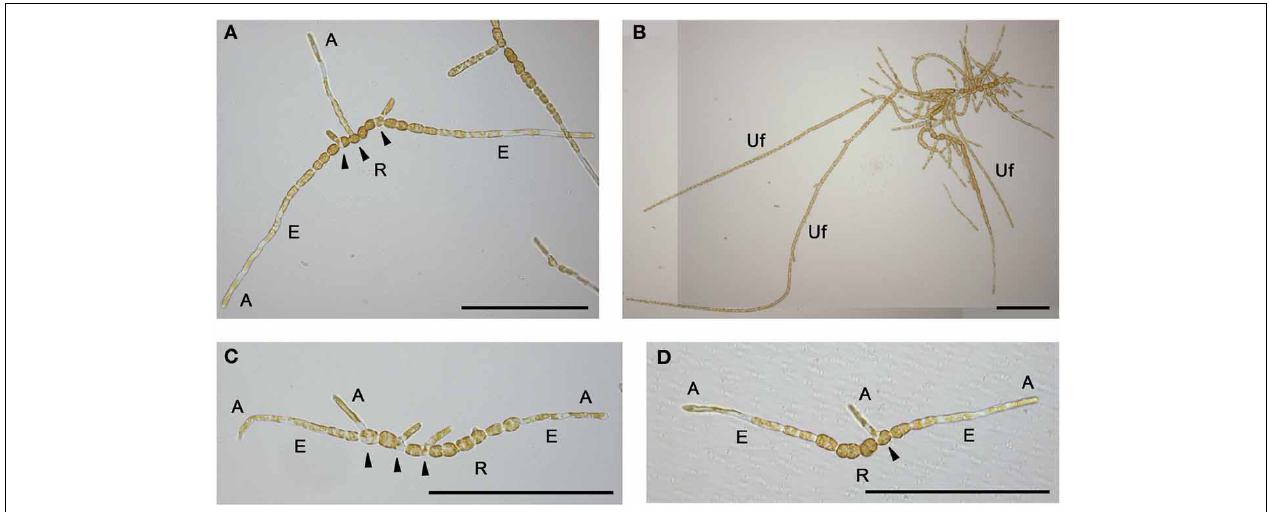
FIGURE 1 | General morphology and on-slide cultivation of Ectocarpus thalli. Early branching prostrate filament (A) and developed thallus showing three upright filaments (B) . Morphology of early prostrate filaments on glass